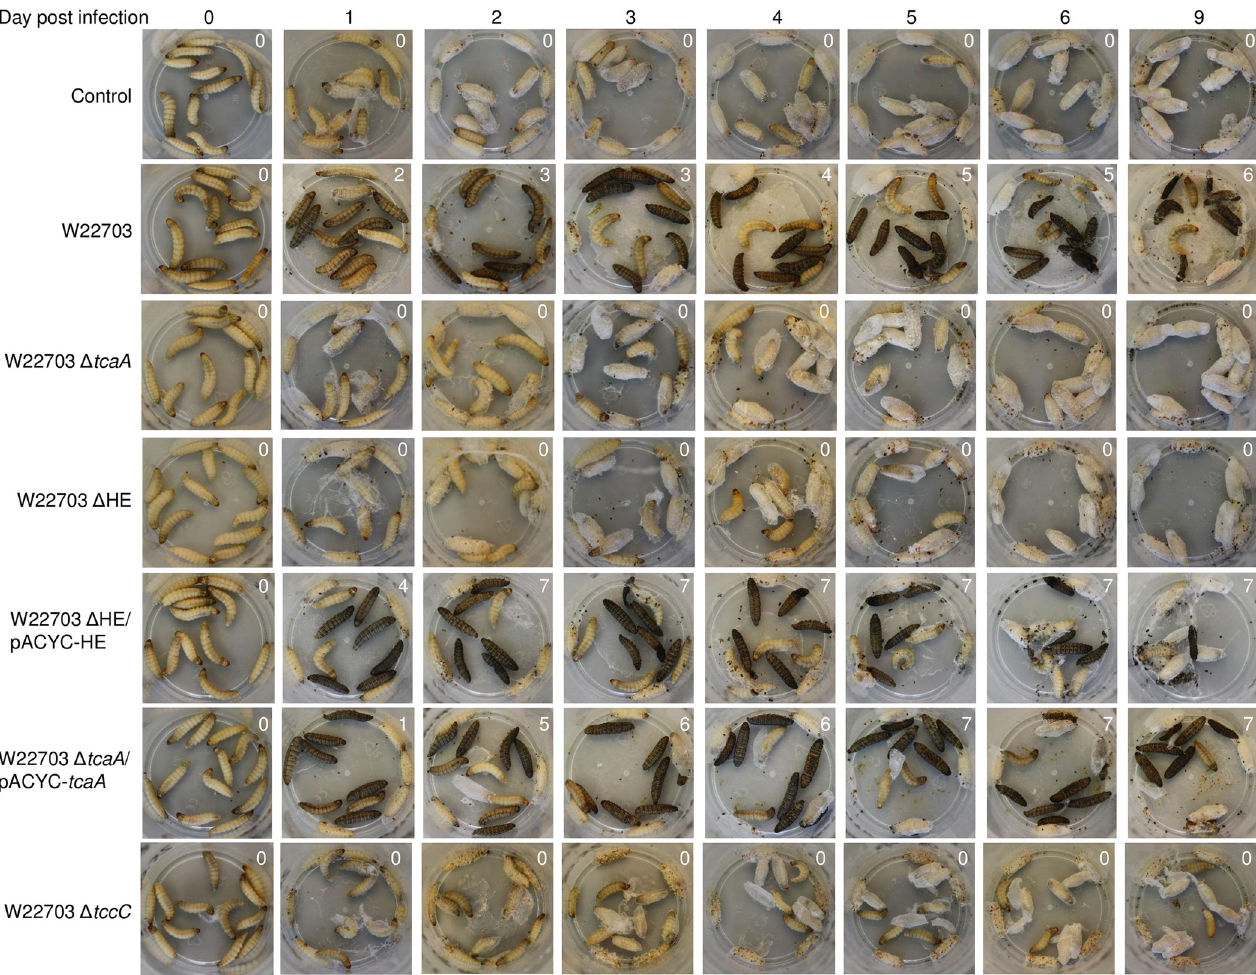
Fig 3. External morphology of larvae following oral infection with W22703 and its mutants. The photos illustrate the outcome of the experiment shown in Fig 2 . Black animals were dead, anthracite ones still alive. The numbers in the upper right angle of each photo indicates dead animals at the respective time- point. Infections with W22703 Δ tccC /pBAD- tccC were not documented by